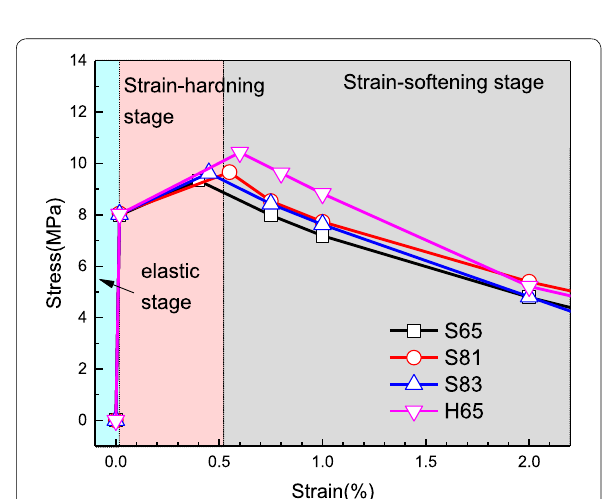
Fig. 18 Direct tensile stress–strain curves for all specimens from inverse